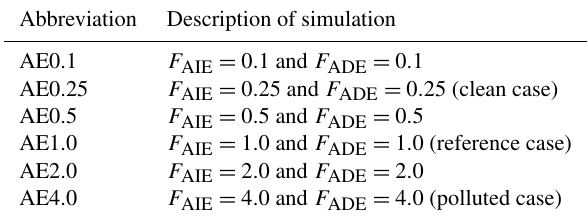
Table 1. Overview of the COSMO-ART realizations capturing the variation in the aerosol amount with respect to the aerosol direct ef- fect (ADE) and aerosol indirect effect (AIE). The realization abbre- viations include the prefix AE (aerosol effect) and the correspond- ing